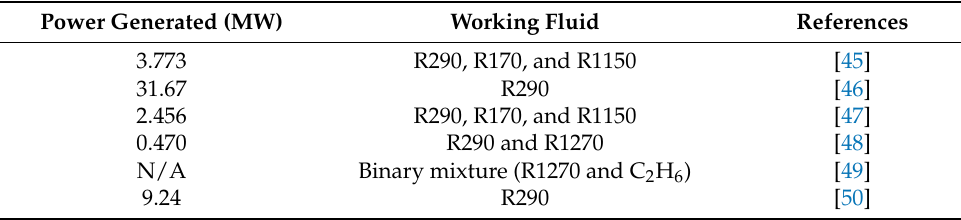
Table 1. Other works utilizing LNG cold energy for ORC power